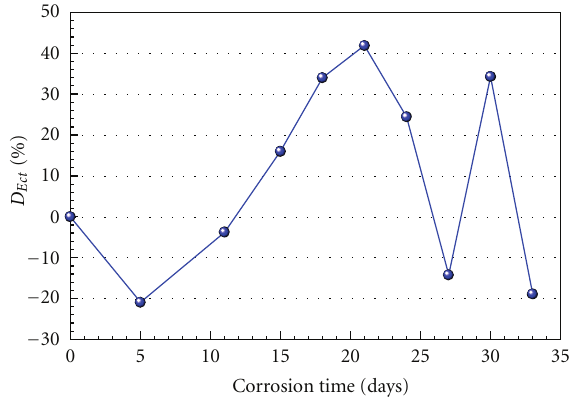
Figure 10: Relation between elastic modulus loss and corrosion duration.